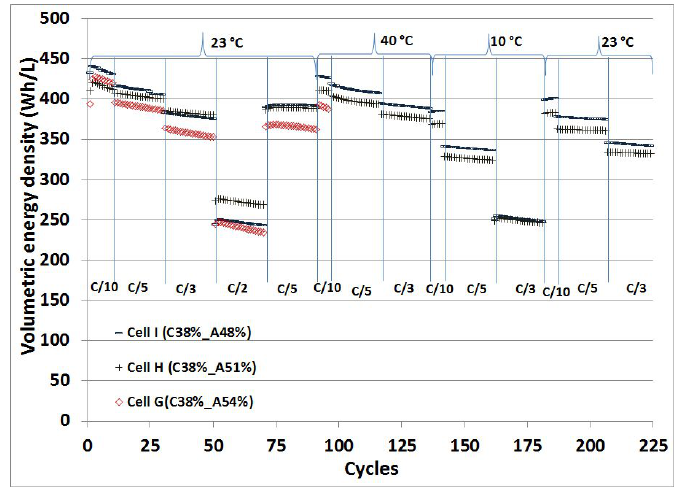
Figure 7. Comparison of the volumetric energy density (Wh/L) values obtained from the full cells, containing electrodes with different porosities, at different C-rates and different